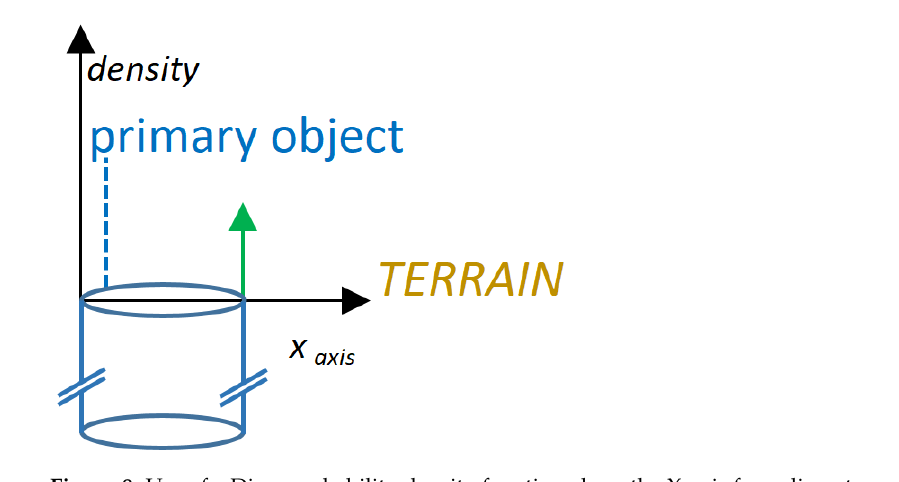
Figure 8. Use of a Dirac probability density function along the X-axis for a diameter completion of a gas network node.